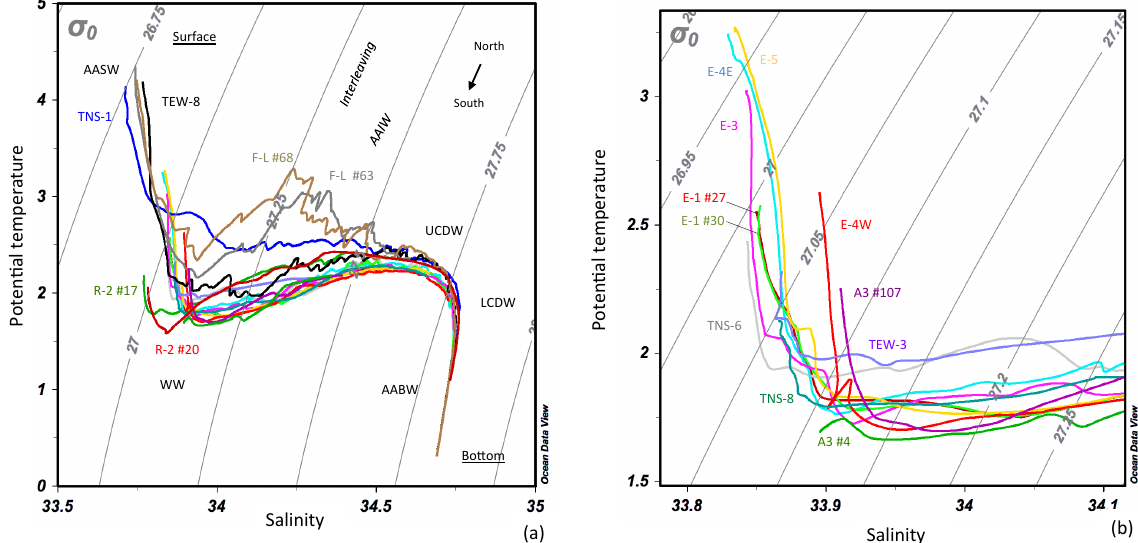
Figure 2. (a) Potential temperature θ –salinity S plots and isopycnals for KEOPS 2 profiles, (b) Focus on the upper 200m water column. AASW: Antarctic Surface Waters, AAIW: Antarctic Intermediate Waters, WW: winter waters, UCDW and LCDW: Upper and Lower Cir- cumpolar Deep Water, AABW: Antarctic Bottom Water. Graph constructed using Ocean Data View (Schlitzer, 2002; Ocean Data View; http://www.awi-bremerhaven.de/GEO/ODV). Table 1. Station locations, cast numbers and bottom depths during KEOPS 2. Depth-weighted average (DWA) values of mesopelagic Ba xs - (pM) and Ba xs -based mesopelagic POC remineralization (MR; mgCm − 2 day − 1 ) integrated between 150–400 and 150–800m depths. See text for further information on calculation.